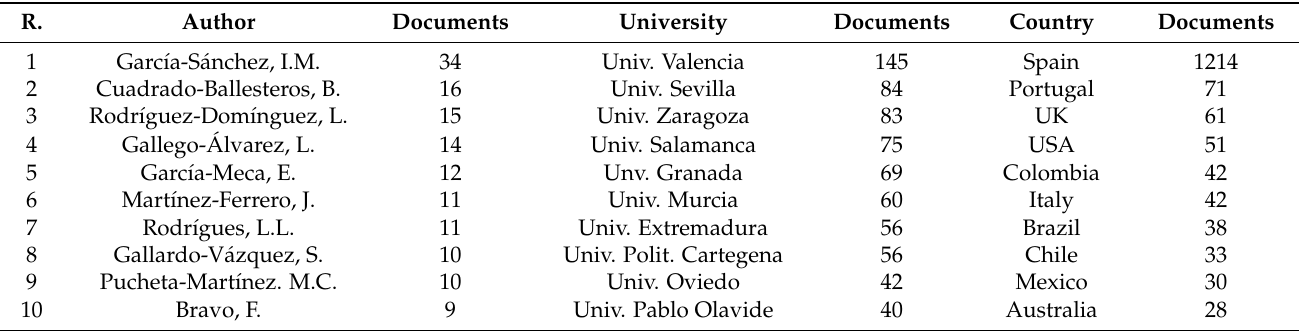
Table 10. Authors, Institutions and Countries that most cite